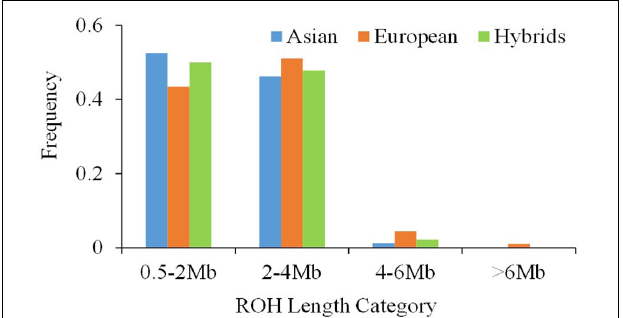
FIGURE 3 | The distribution of the single runs of homozygosity (ROH) length classes within the Asian, European and hybrid pear ( Pyrus spp.)